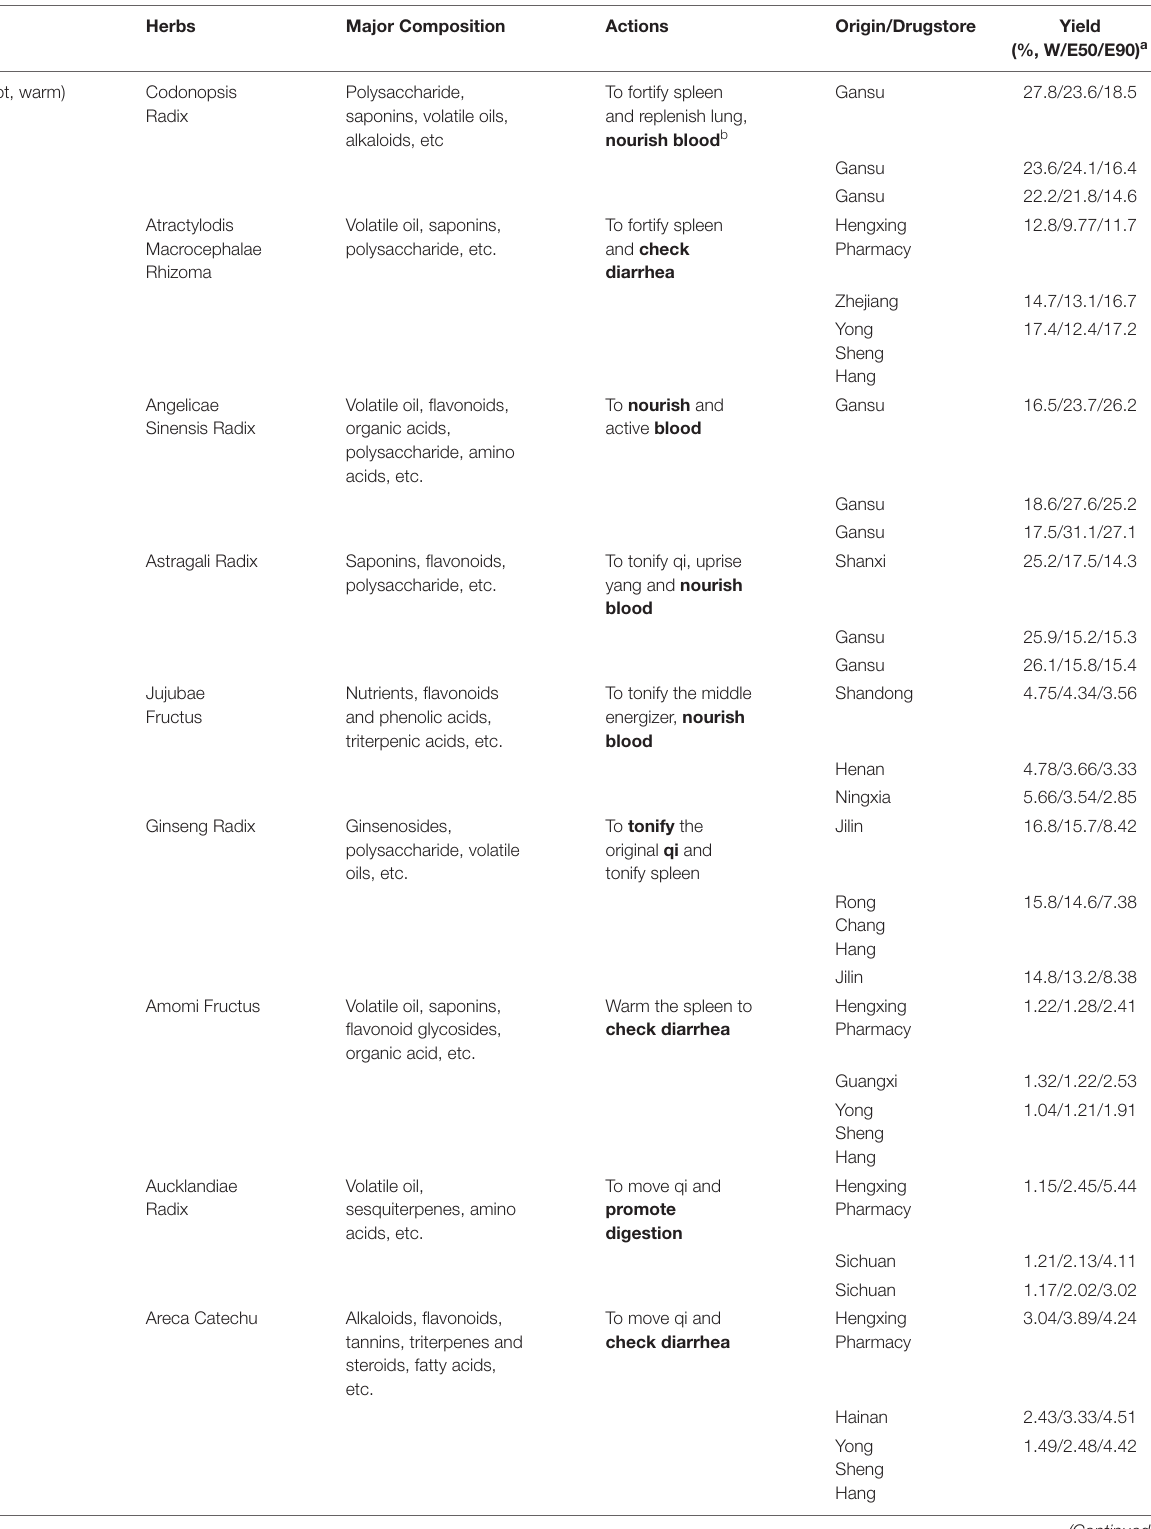
TABLE 1 | The pharmacological action, origin and extracting yields of the tested 15 spleen-meridian herbs.